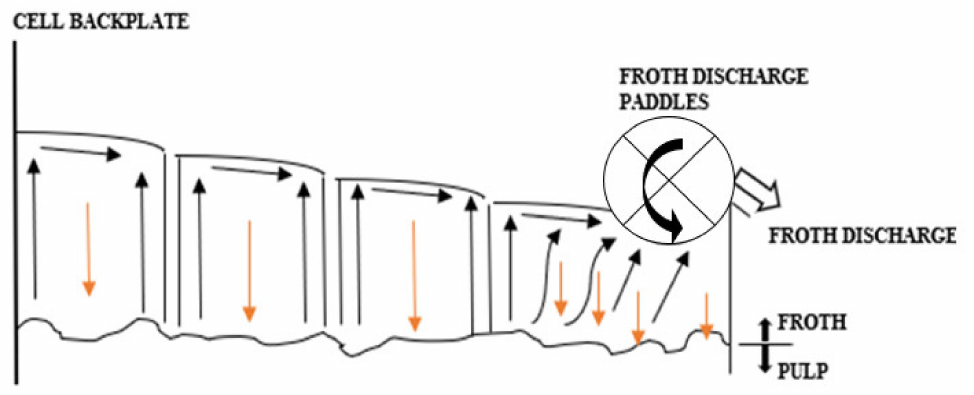
Figure 8. Mechanical paddles